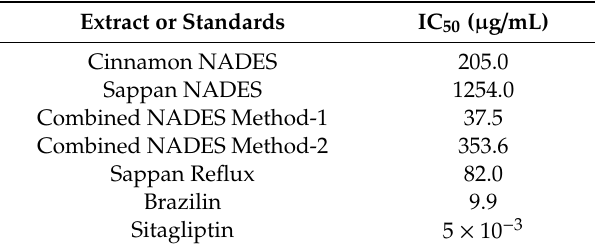
Figure 3. Dipeptidyl peptidase IV (DPP IV) Inhibitory Activity of extracts and standards. Table 1. DPP IV IC 50 of extracts and standards.